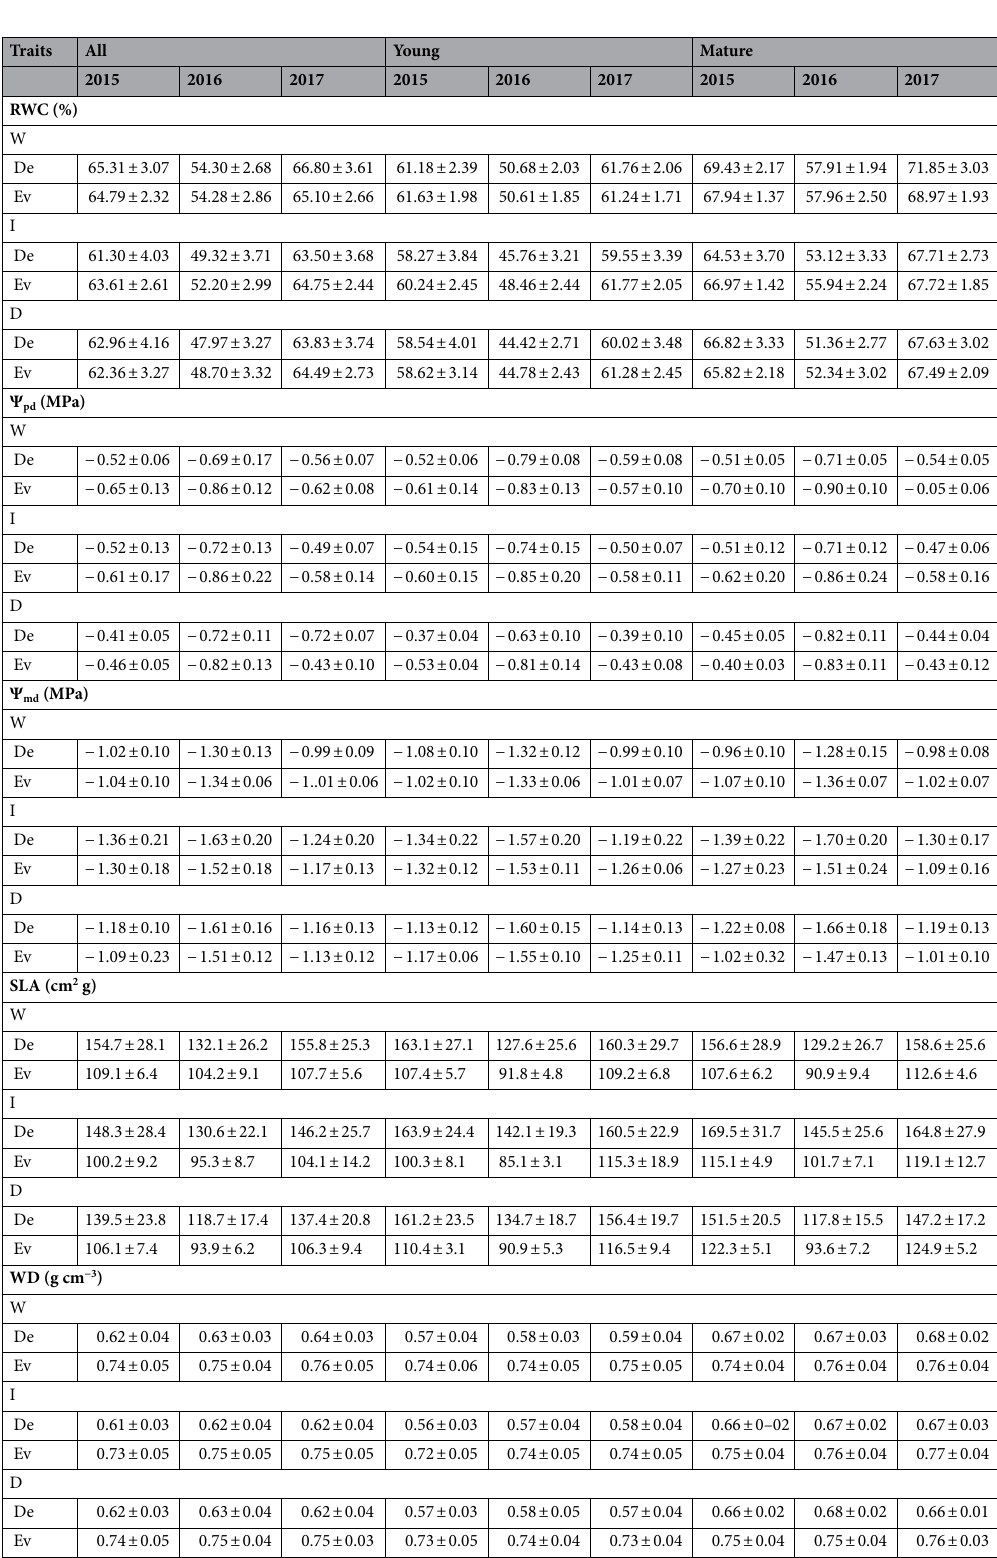
Table 1. Functional traits of deciduous and evergreen species from 2015 to 2017. Data are means ± SE. W wet site, I intermediate site, D dry site, De deciduous, Ev